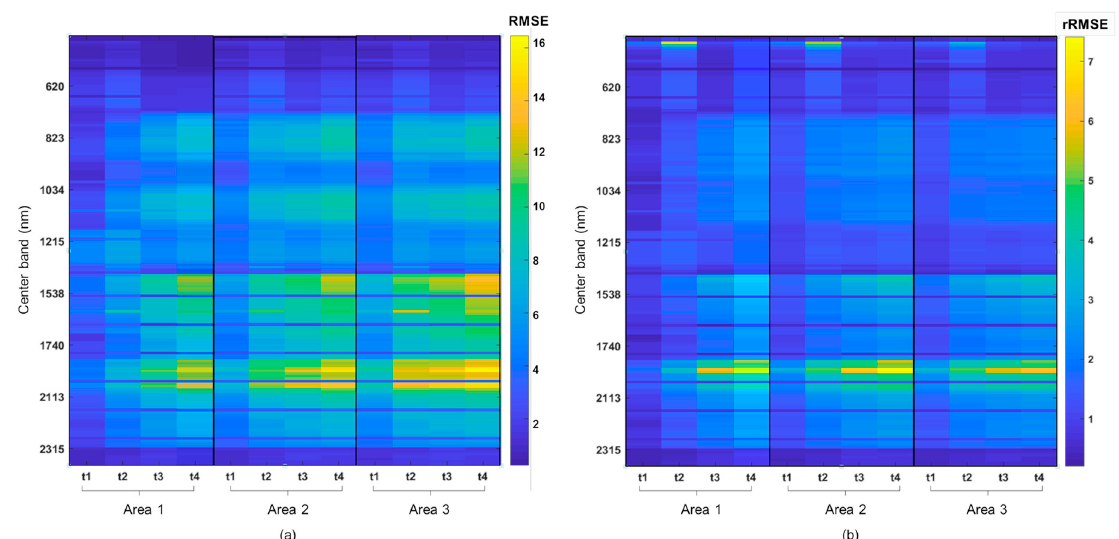
Figure 11. Evaluation results of the gap-filling spatiotemporal model showing: ( a ) color-scale image of the RMSE (% of absolute reflectance units) for each one of the 166 bands (rows) per prediction time (columns) and arranged in ascending order from left to right according to the sampled area. ( b ) Color-scale image of the corresponding rRMSE achieved (% units).